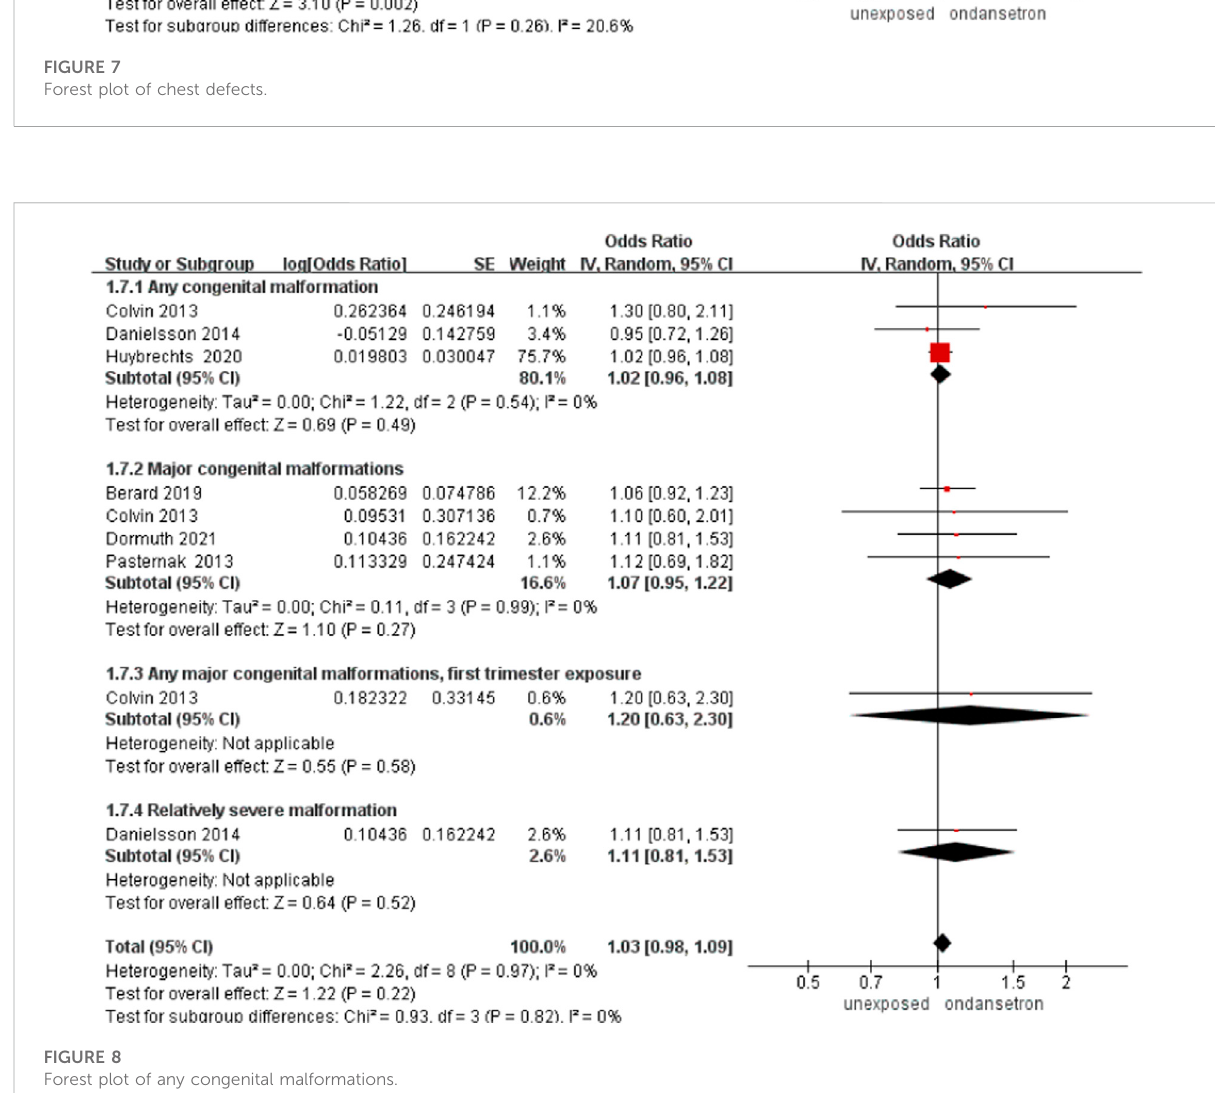
FIGURE 8 Forest plot of any congenital